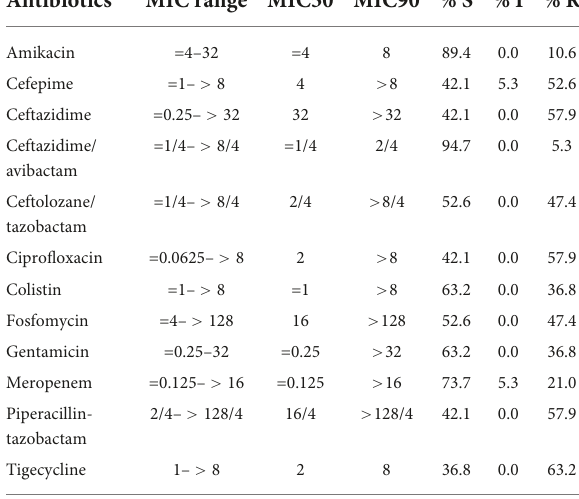
TABLE 1 Antimicrobial susceptibility testing results for HMV isolates included in the study.